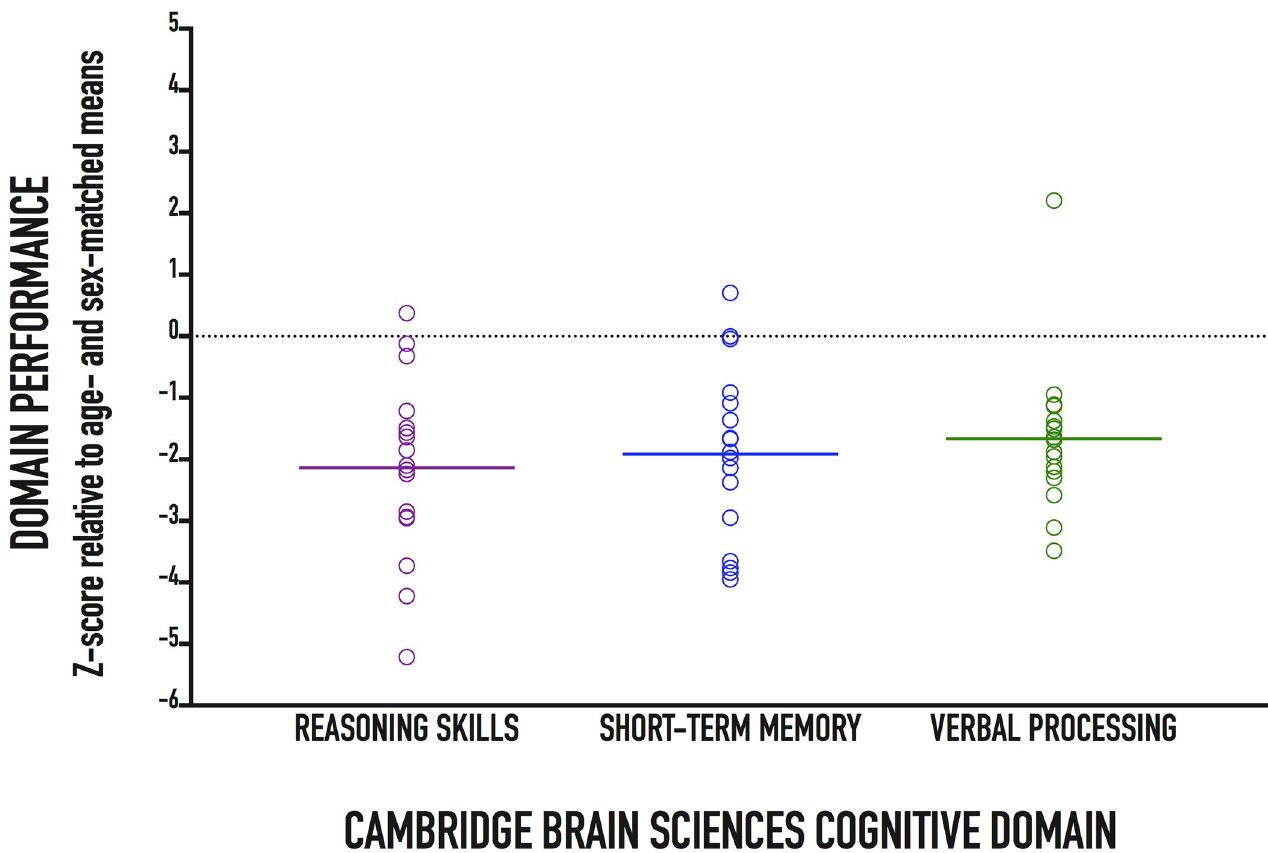
Fig 3. Patient performance on the three Cambridge Brain Sciences cognitive domains: reasoning skills, short-term memory, and verbal processing. Individual patient (circles) and cohort (solid lines) test performance on each cognitive domain presented as z-scores corrected for age and sex. By design, healthy norm mean = 0 and standard deviation = 1.